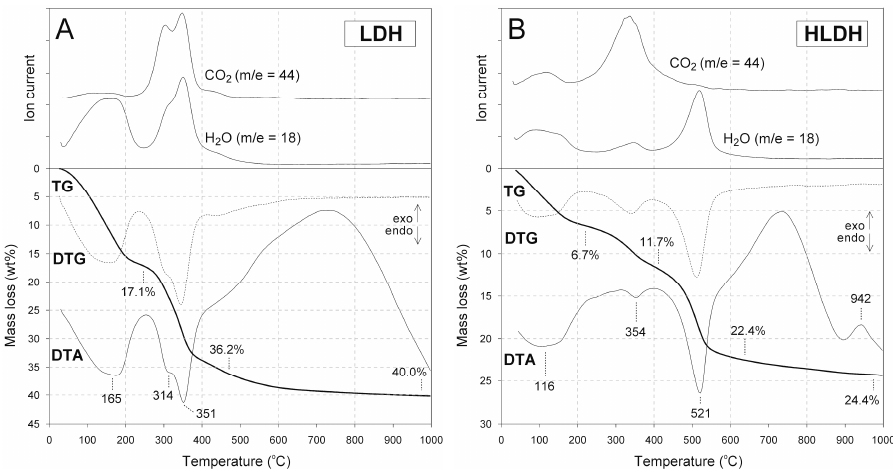
Figure 4. Thermal curves of ( A ) LDH and ( B ) H-LDH.